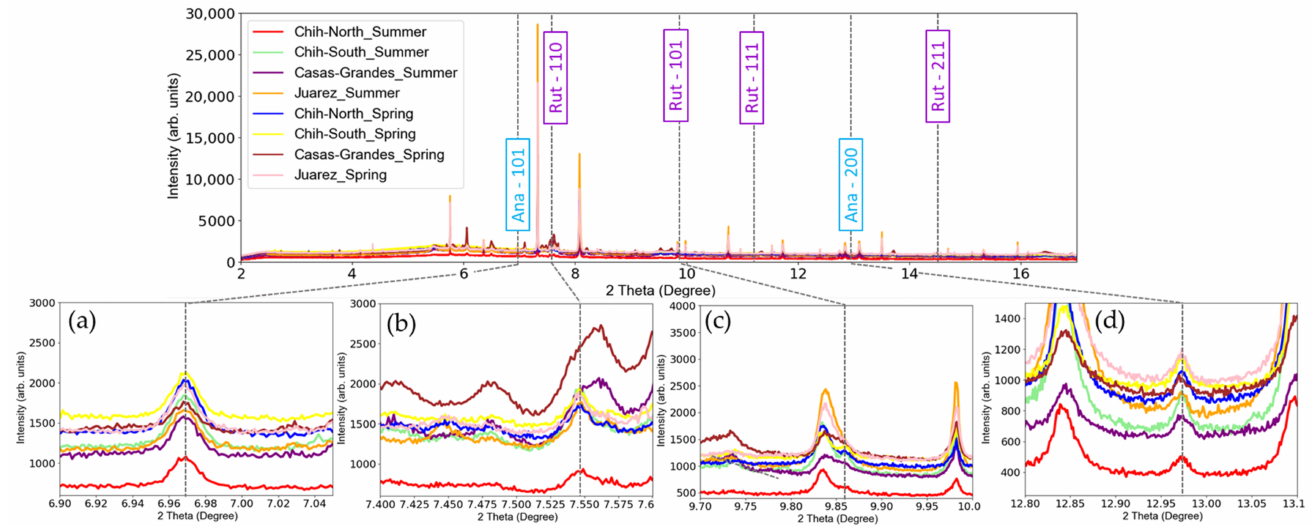
Figure 3. XRD diffraction spectra from all sludge samples. Zoomed regions are shown for the most important diffraction peaks of anatase (Ana) and rutile (Rut): ( a ) anatase 101; ( b ) rutile 110; ( c ) rutile 101 and ( d ) anatase 200. A small vertical shift has been applied for visualization purposes